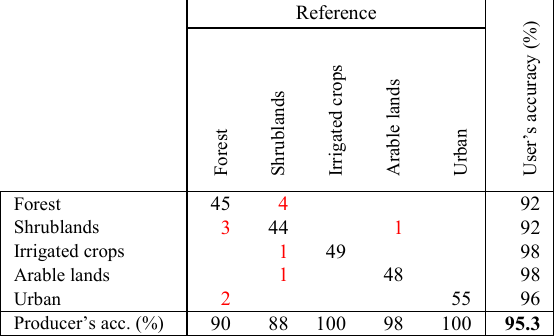
Table 3. Confusion matrix of the classification combining Landsat 7 ETM+ and TerraSAR-X data.